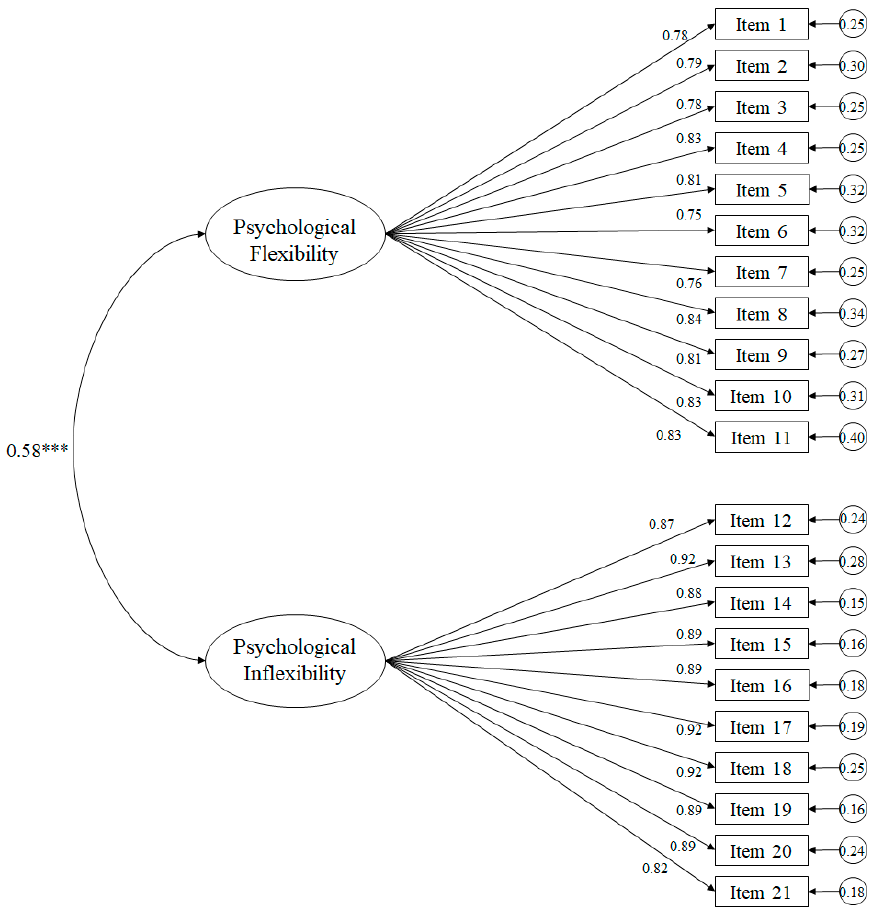
Figure 1. Confirmatory factor analysis of the Acceptance and Action—Stigma Scale. The ellipses represent the factors and the rectangles represent the specific items. Residual variances are presented in the small circles. Note: *** p < 0.001